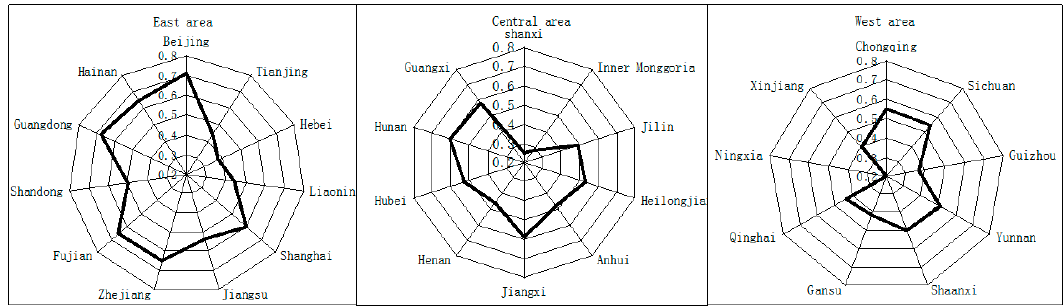
Figure 4. Comparison of the average low-carbon economy level of the three areas.